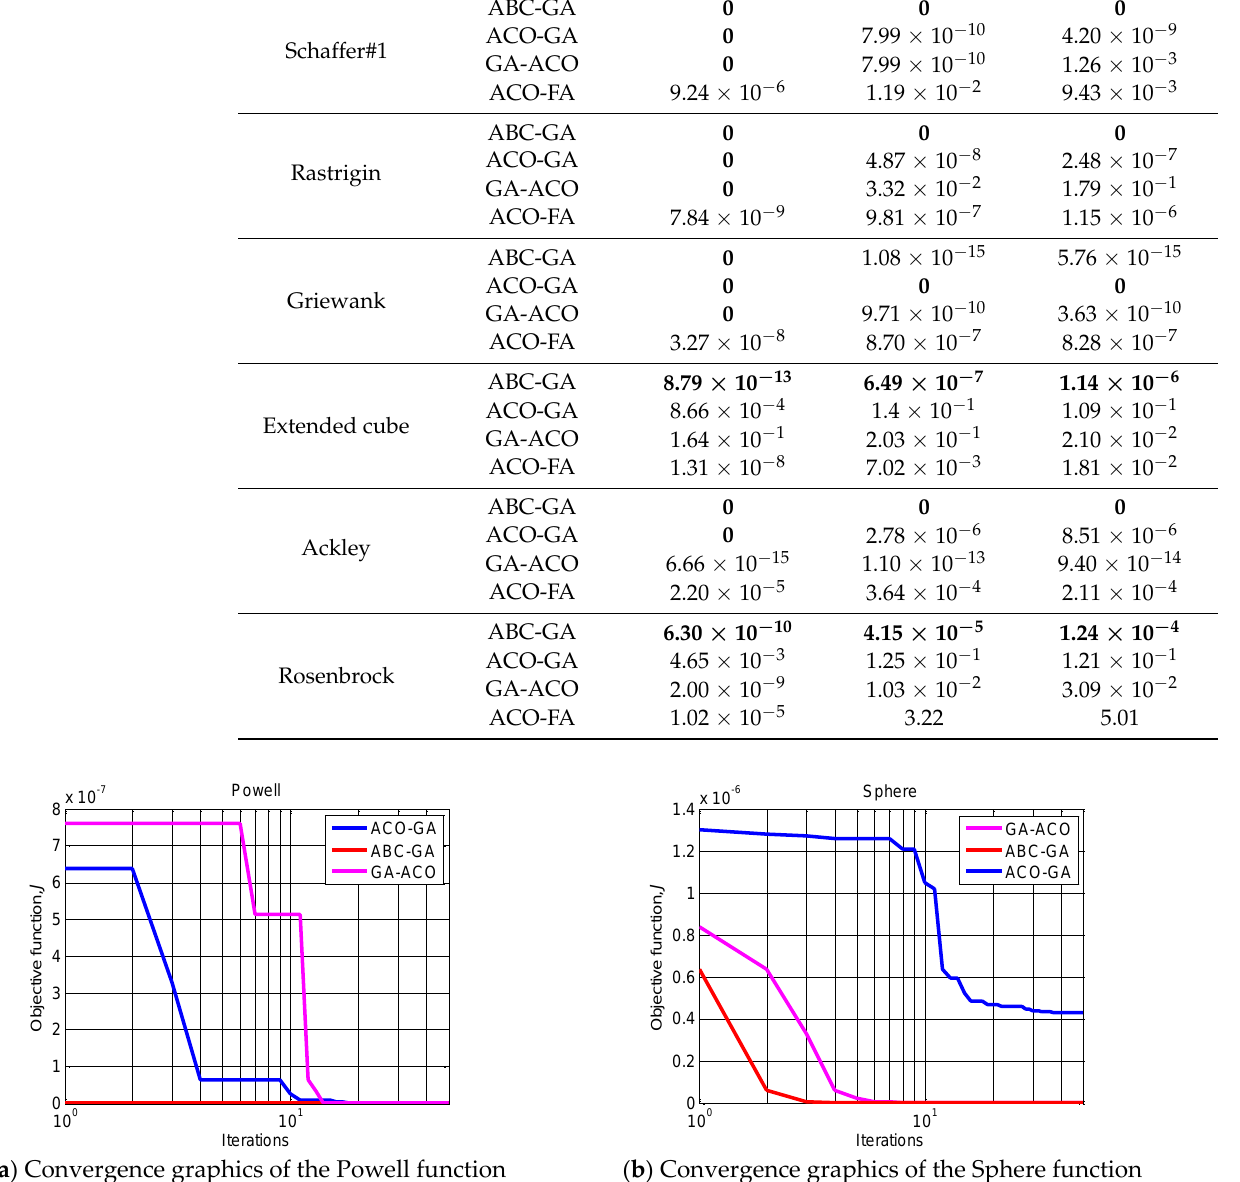
Figure 2. Convergence graphics.